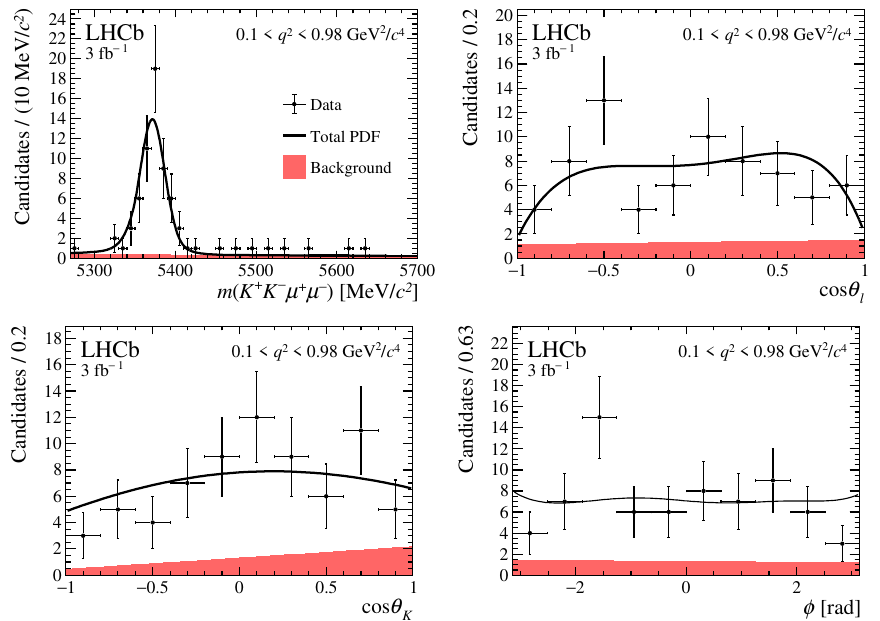
Figure 12 . Mass and angular distributions of B 0 0 . 1 < q 2 < 0 . 98 GeV 2 /c 4 for data taken in 2011–2012. The data are overlaid with the projections of the fitted PDF.